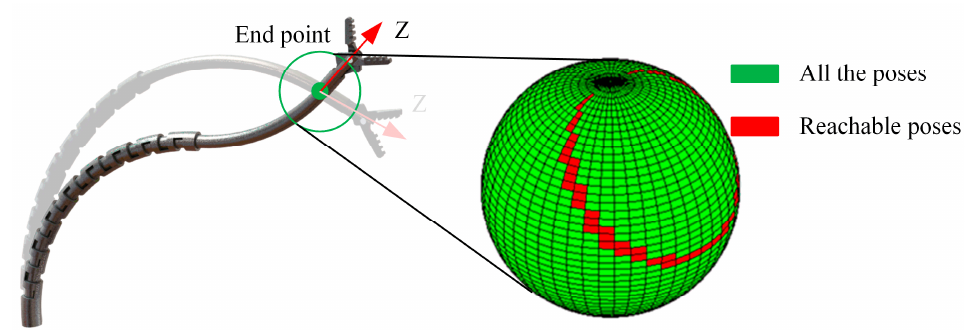
Figure 8. Cross-section of the robot workspace under the current configuration. The end pose of the robot is represented by θ 0 and ϕ 0 in the Cartesian coordinate system. The end posture of the CCR can be expressed by Equation (16). The Rotz ( ϕ 0 ) is the rotation matrix around the X-axis. The Rotz ( ϕ 0 ) is the rotation matrix around the Z-axis. The X-axis and Z-axis are divided into n 1 and n 2 parts. The dexterity of the point can be represented by the graph which the X-axis and Z-axis form. Using the graph, the dexterity value of this point can be calculated using Equation (17).